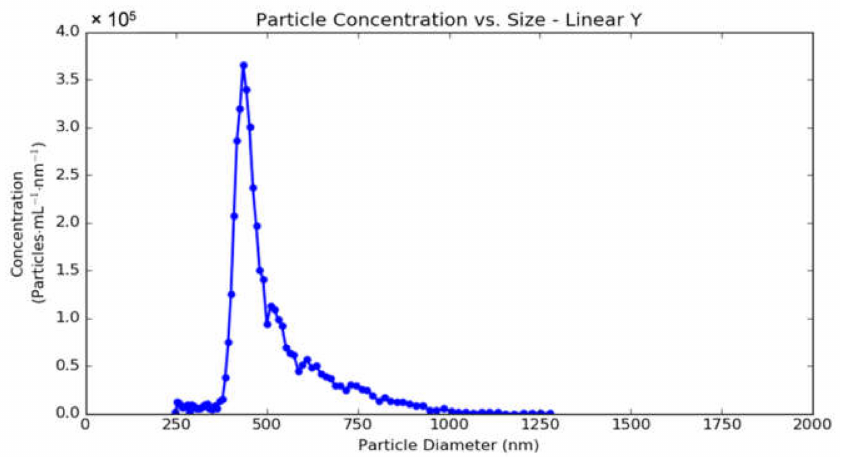
Figure 7. The concentration density function of the F-HOP sample as determined by MRPS. A 100-fold dilution was applied to meet the measurement range of the instrument. The total concentration of the particles as calculated from the area under the curve was 4.26 × 10 9 mL − 1